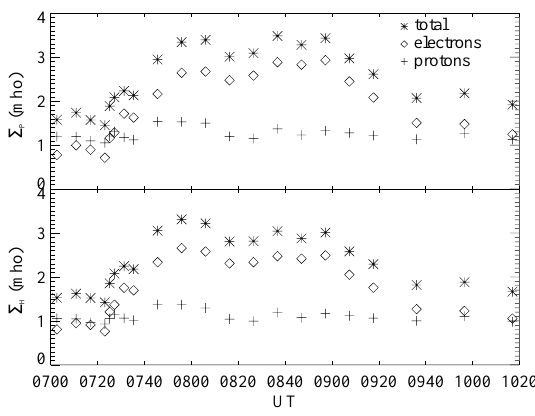
Fig. 8. Idem Fig. 6 with conductances averaged over the dusk sector (MLAT between 60 ◦ and 70 ◦ and MLT between 18:00 and